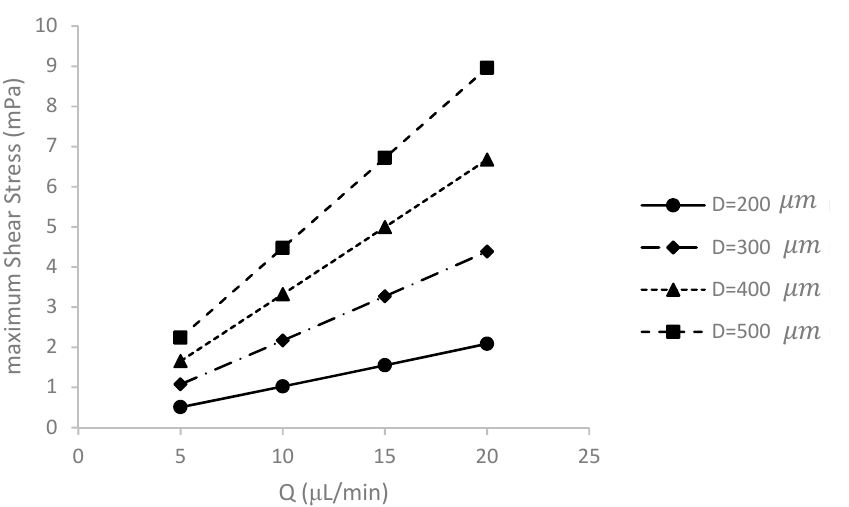
Figure 6. The effect of variation of the culture medium volume flow rate Q and spheroid diameter D on the maximum shear stress applied to the surface of the spheroid. In all cases, the maximum shear stress is well below the shear stress threshold of 25 mPa for cancer cells.